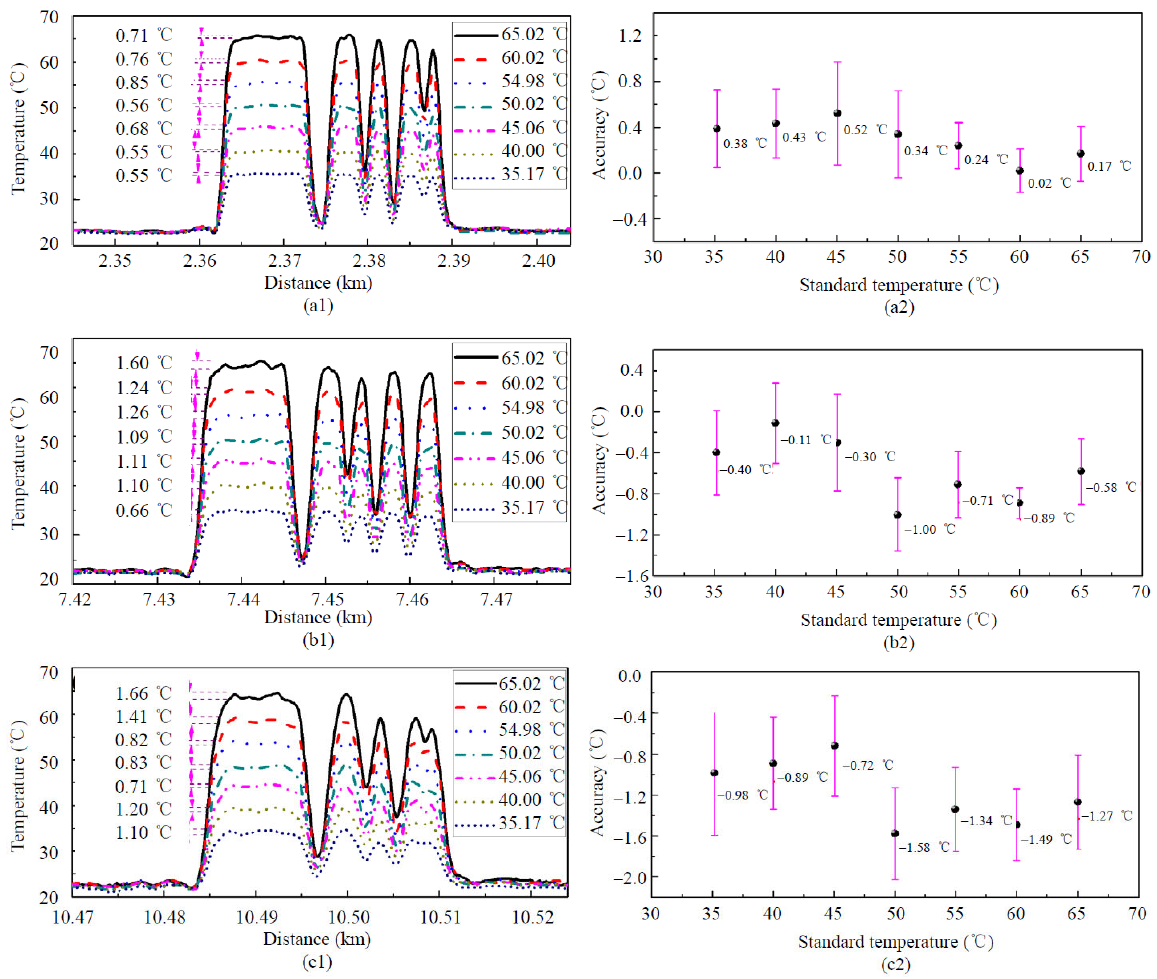
Fig. 8 Results of measured temperature in detail and the accuracy and uncertainty of the results at different test zones at: (a) Test 1, (b) Test 2, and (c) Test